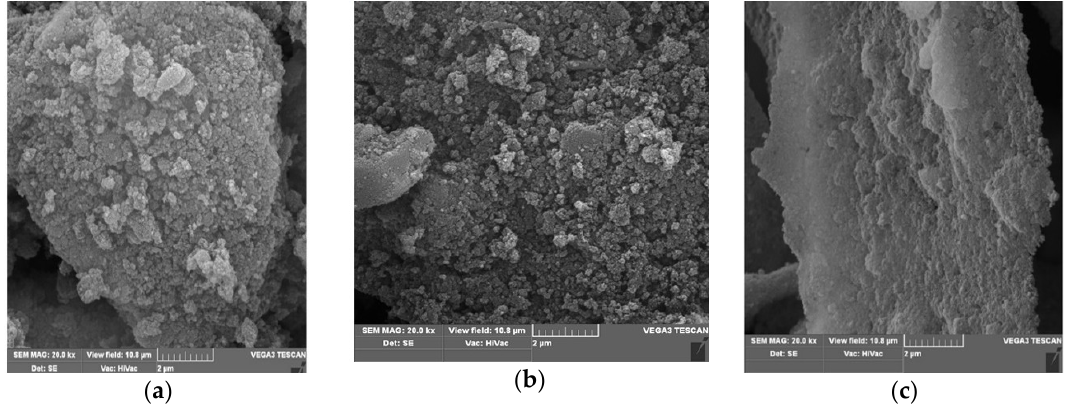
Figure 10. SEM microscopic pictures: ( a ) non-treated NDP (starting material); ( b ) olefinized NDP derivative obtained by laser modification; ( c ) NDP 5 chemically modified with an isokinetic mixture contained 1,5-diaminonaphthalene and p-aminobenzoic acid.